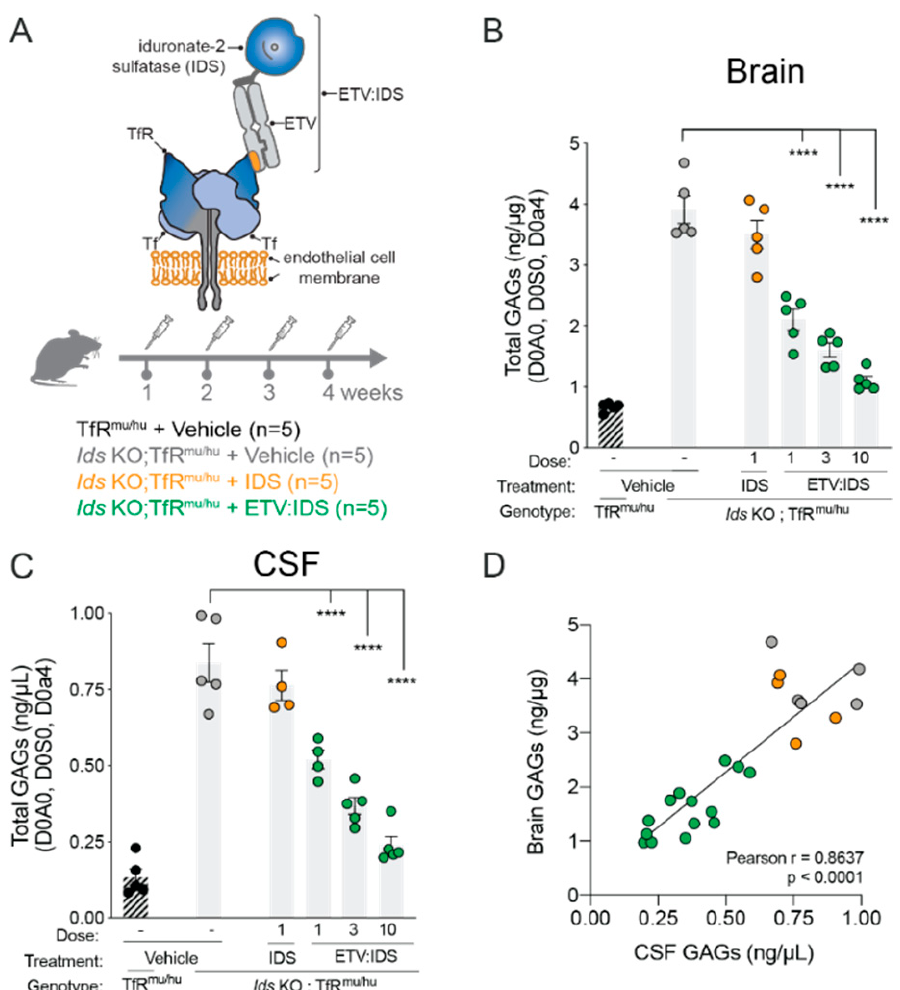
mu / hu KI mice. GAG levels